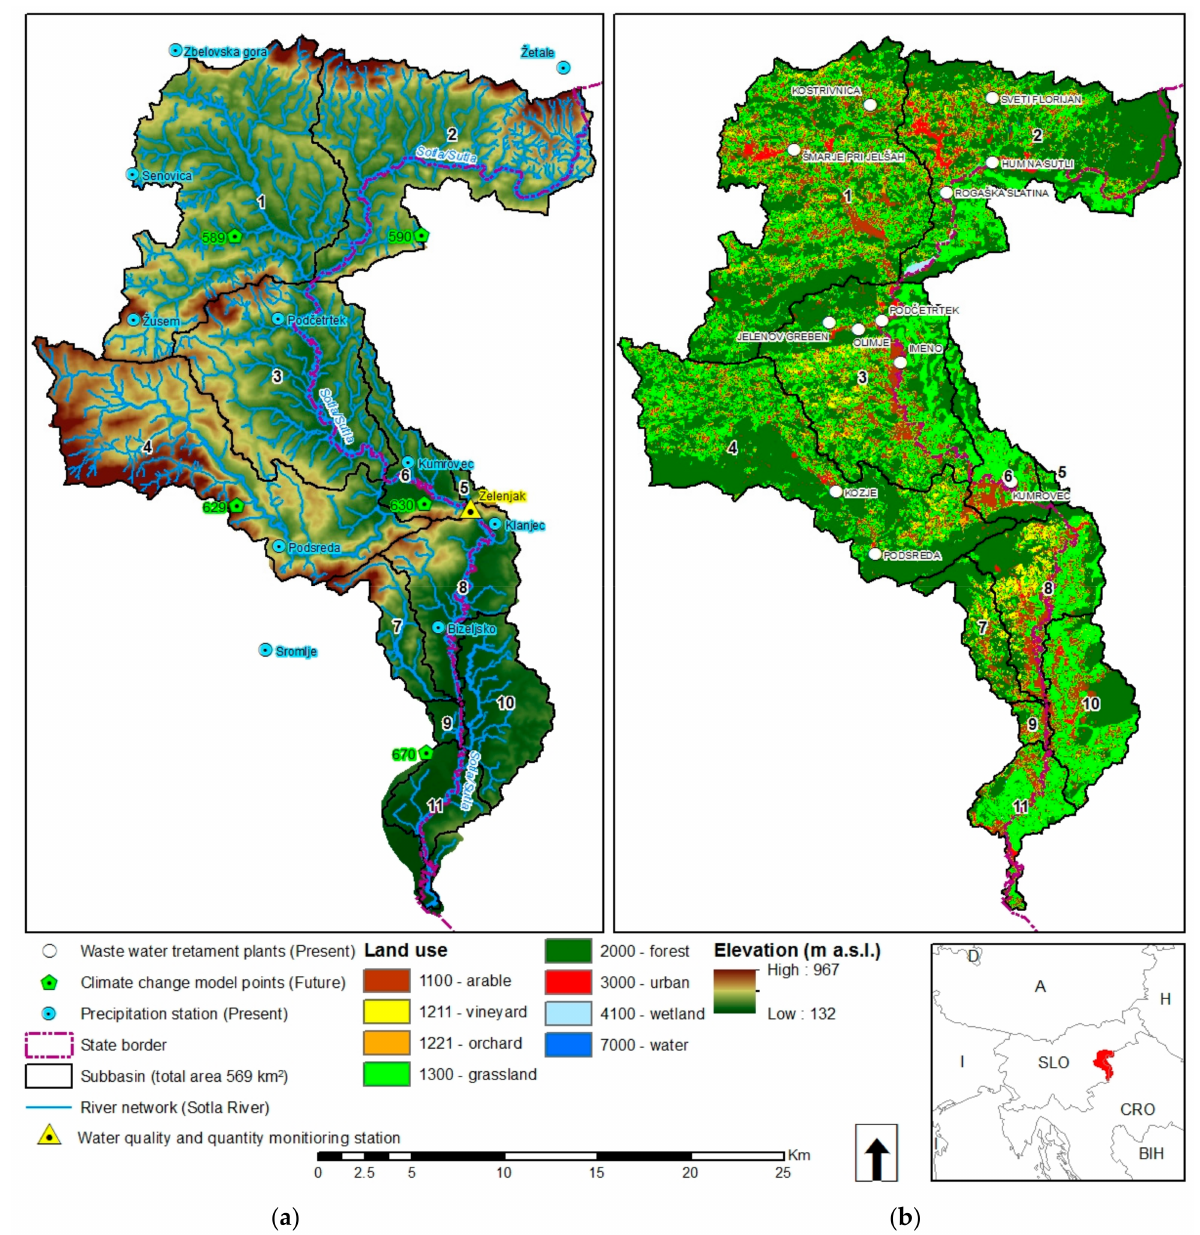
Figure 1. Transboundary Sutla river basin: ( a ) river network and subbasins, precipitation stations, and climate change model points; ( b ) land use of the Sutla river basin, river network, and subbasins and UWWTPs. Data source: Geodetic Survey of the Republic of Slovenia, Ministry of Agriculture, Forest and Food RS, Ministry for Agriculture RH, Ministry of Environment and Spatial planning RS, Copernicus Land Monitoring Service EU, Year: